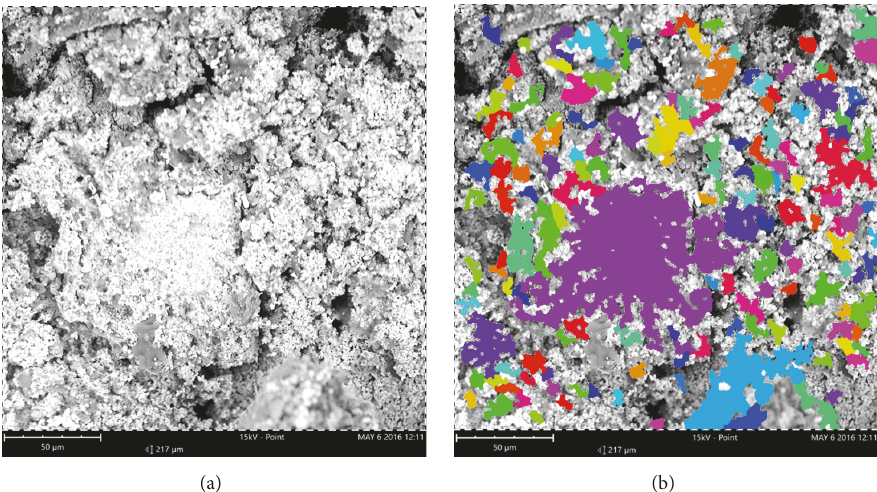
Figure 1: SEM + EDS analyses of the T. grandis capped silver-nanoparticle material. (a) Image from scanned electron microscope. (b) Clusters of particles colouring by ParticleMetric rendering of the scanned microscopic